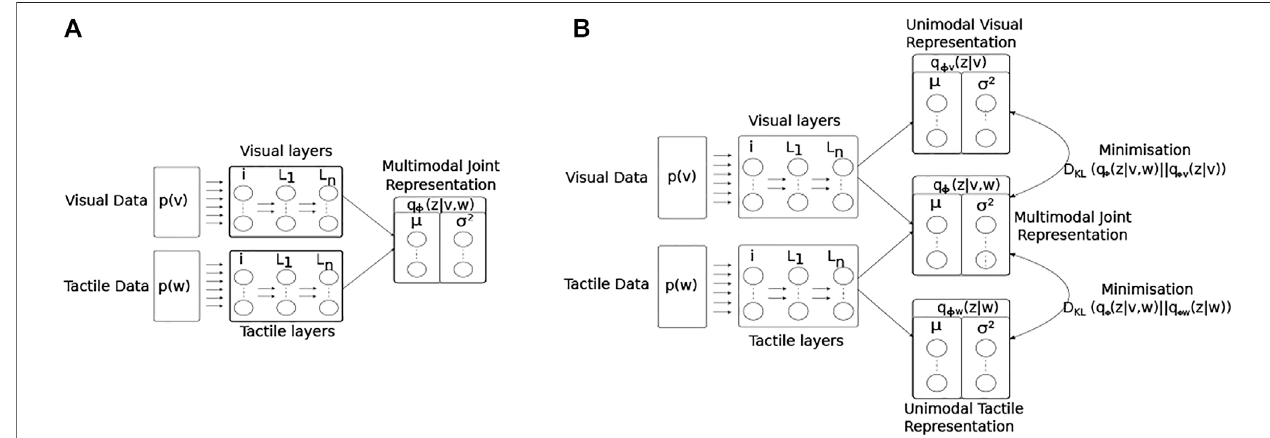
FIGURE14| ArchitecturaldiagramsoftheencodernetworksofthetwoJMVAEmodels; (A) JMVAE-zero,and (B) JMAVAE-kl.Bothnetworksattempttorepresent thetwoinputmodalities(visual p ( v )andtactile p ( w ))asajointmultimodallatentrepresentation q ϕ ( z | v , w ).Thisisdonebyminimisingboththereconstructionerrorforeach modality, and the KL-divergence ( D KL ) between a standard normal distribution and the joint multimodal distribution. The resulting continuous distribution is encoded by the activity of two parallel layers of nodes representing the mean and variance ( μ , σ 2 ) of each latent dimension. The JMVAE-kl model trains 2 further encoders, one usingonlyvisualinput q ϕ v ( z | v )andtheotheronlytactile q ϕ w ( z | w ),suchthattheKL-divergencemeasuresbetweentheunimodalandmultimodalapproximatedistributions can be included into the loss function during training.